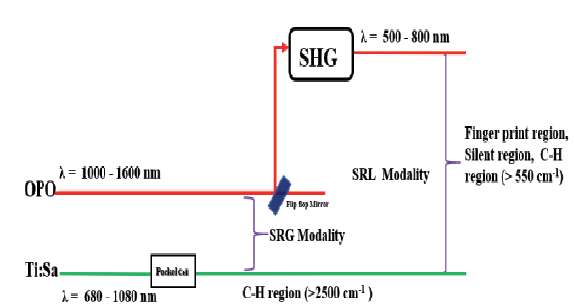
Figure 1. Generation system with combination Ti:Sa- OPO (SRG modality) and Ti:Sa-SHG (SRL modality). In order to demonstrate its successful realization SRG and SRL images of polystyrene beads with a diameter of 3 μm are reported in figures 2 and 3, respectively, along with transmission image (TI). All the images are single recordings of 512 px × 512 px, and their acquisition